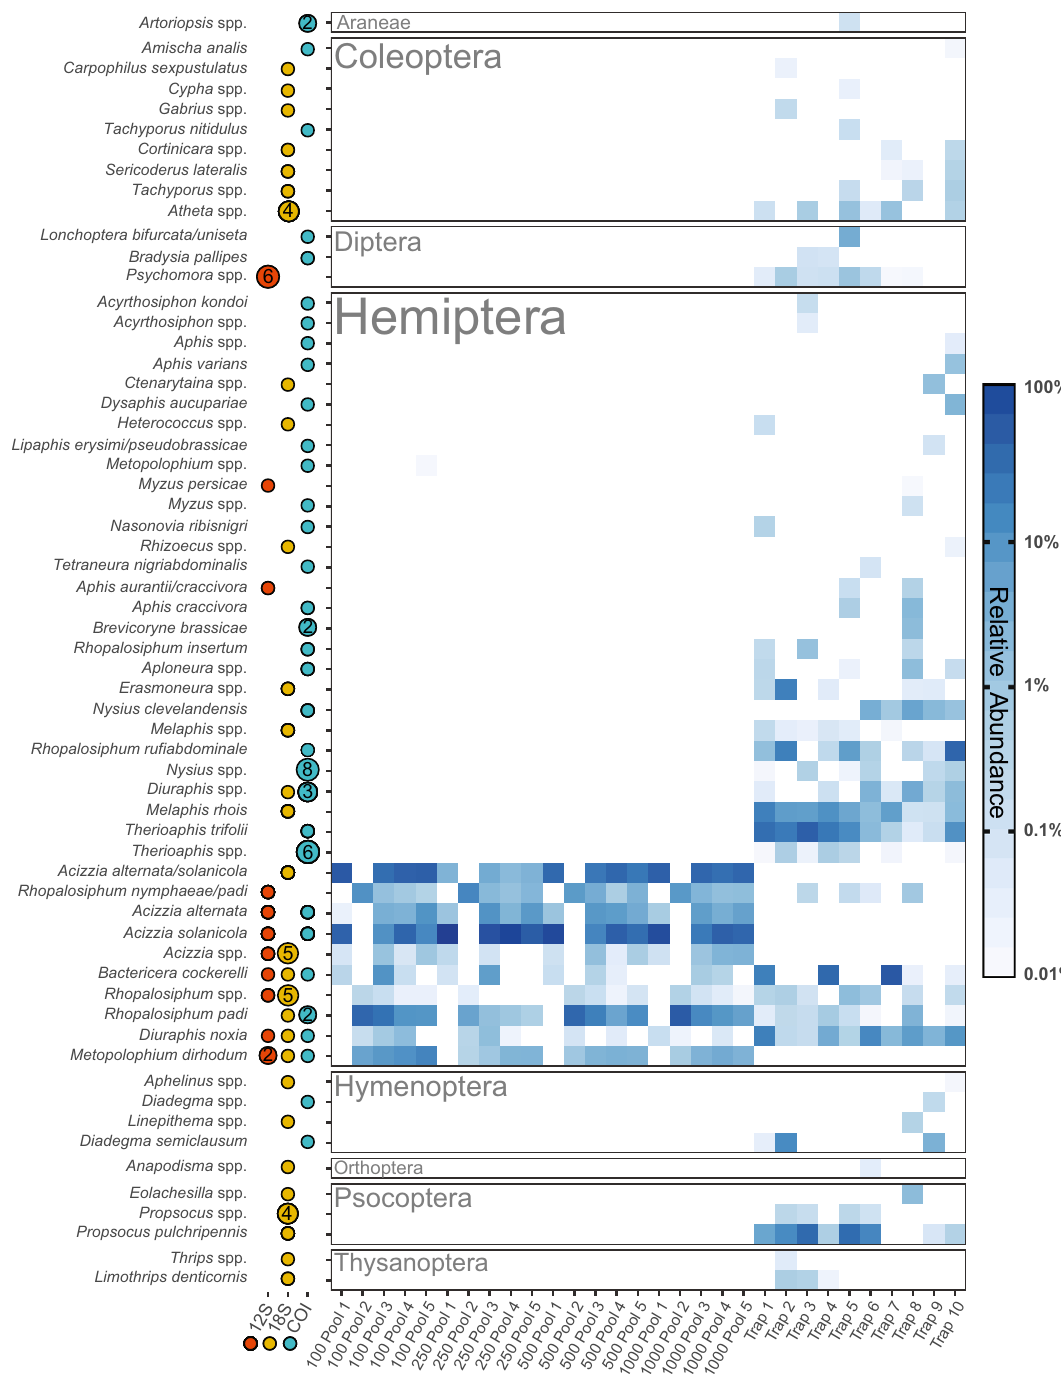
Figure 5. Heat map displaying the relative abundance of different Arthropoda taxa in both mock community and field trapped insect samples based on sequencing reads. Taxa designated ‘spp.’ denote genus-level classification. The loci contributing to detection of each taxa is indicated by a red (12S), yellow (18S), or blue (COI) dot. The size and number inside the dot indicate if more than one amplicon sequence variant (ASV) was assigned to the taxonomic rank. Mean relative abundances across all three amplicons are displayed on a log10 scale. Only ASVs that could be reliably classified to genus with a relative abundance above 0.01% are